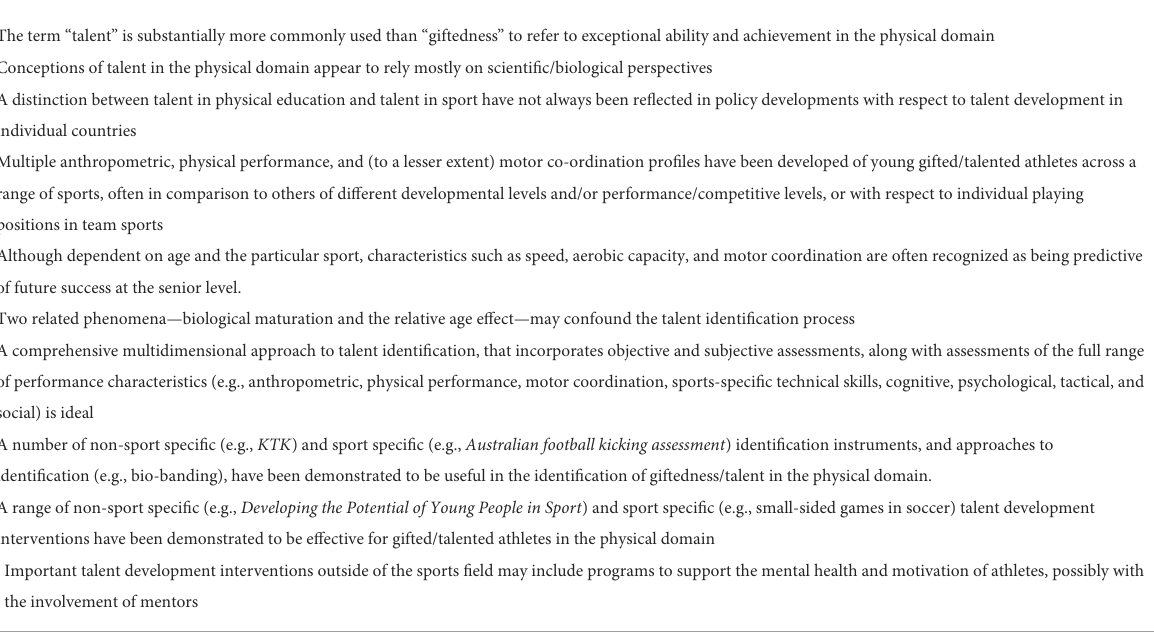
TABLE 2 Key findings on the identification and development of giftedness/talent in the physical